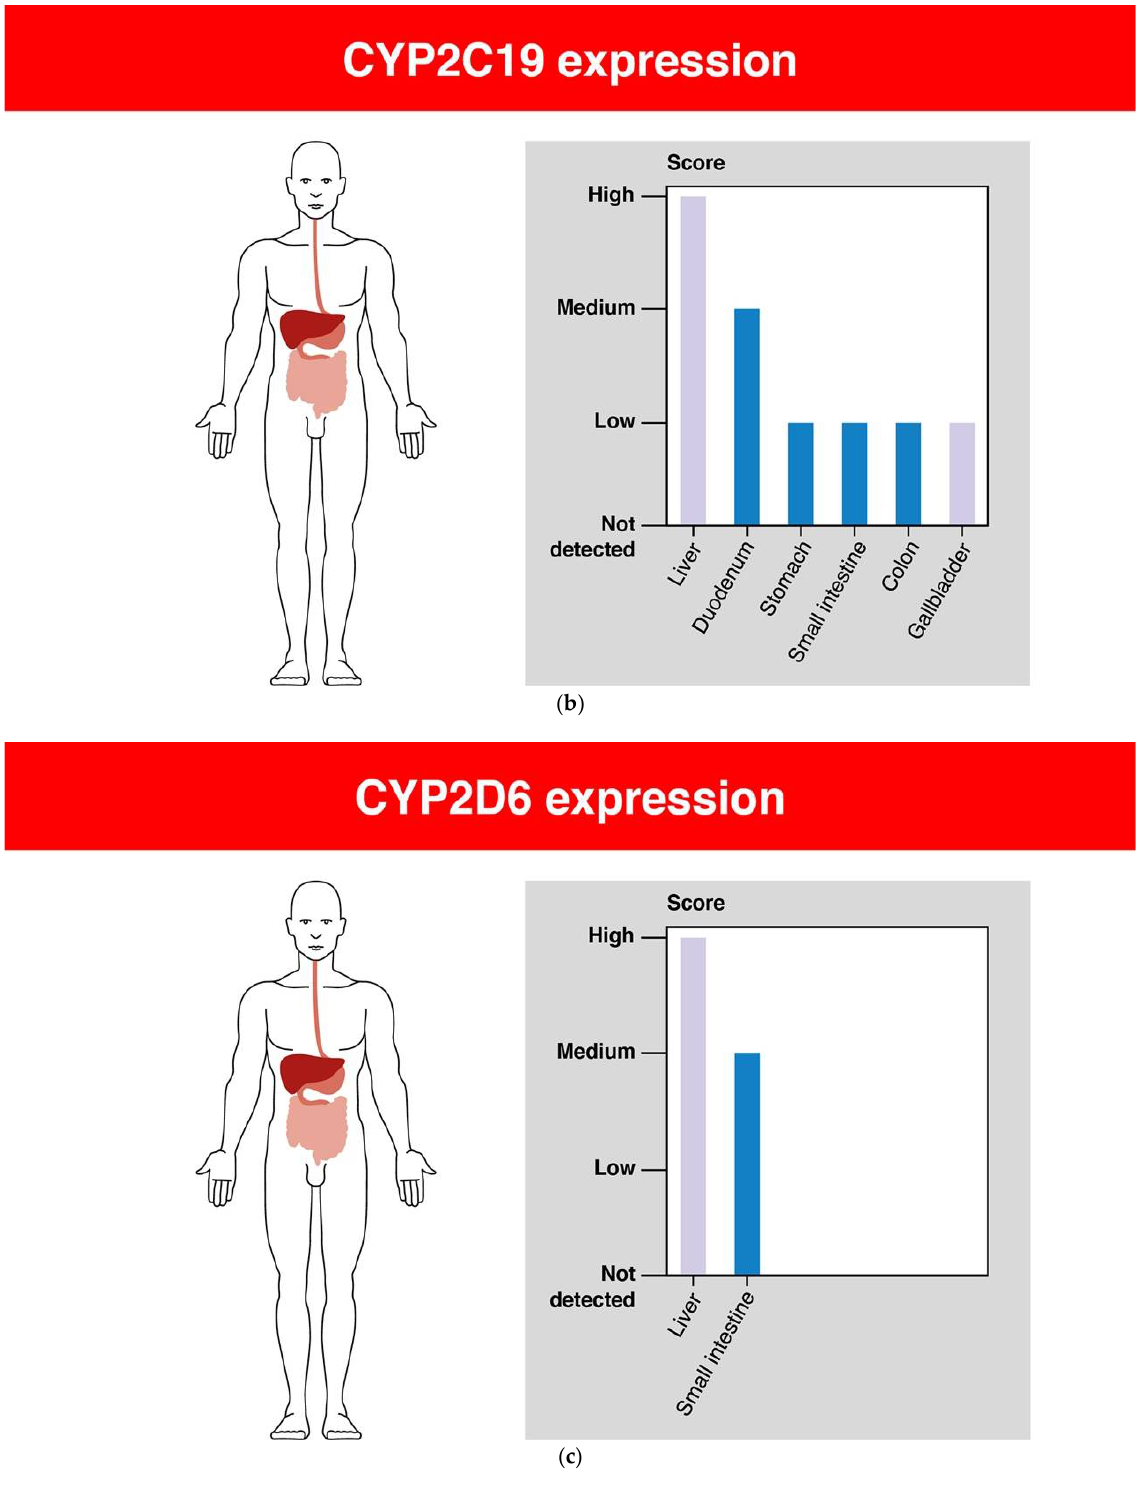
Figure 3. The expression of some CYP enzymes in the human body: ( a ) CYP3A4; ( b ) CYP2D6; ( c ) CYP2C19 ([33], modified by the authors). Phase I, involving CYP, has an oxidative and a reduction reaction. Synthesis of NADPH is dependent on cytochrome P450 reductase. The cofactor NADPH is involved in the reduction of oxygen to water in the general reaction where AP is